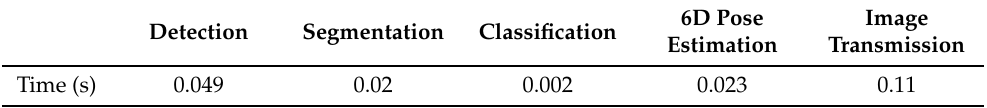
6D Pose Image Estimation Transmission